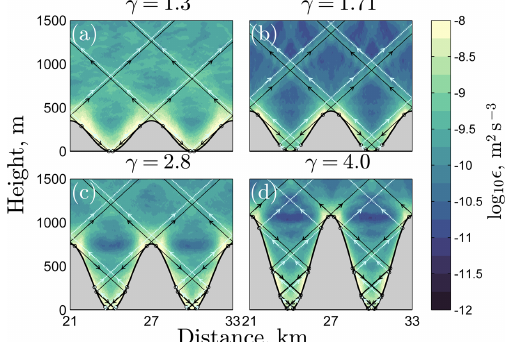
Figure 6. Internal tide characteristics superimposed on tidally-averaged energy dissipation rates (m 2 s − 3 ) for a subset of the simulations shown in Figure 5. The simulations all have λ x = 6 km and varying values of γ : (a) γ = 1.3, (b) γ = 1.71, (c) γ = 2.8, (d) γ = 4.0, with f = 0. The x -axis shows distance (km), and the z -axis shows height above the sea-floor (m). The characteristics emanating from the top of the slopes are shown in black; following reflection in the troughs the characteristics are shown in light blue. Arrows indicate the direction of energy